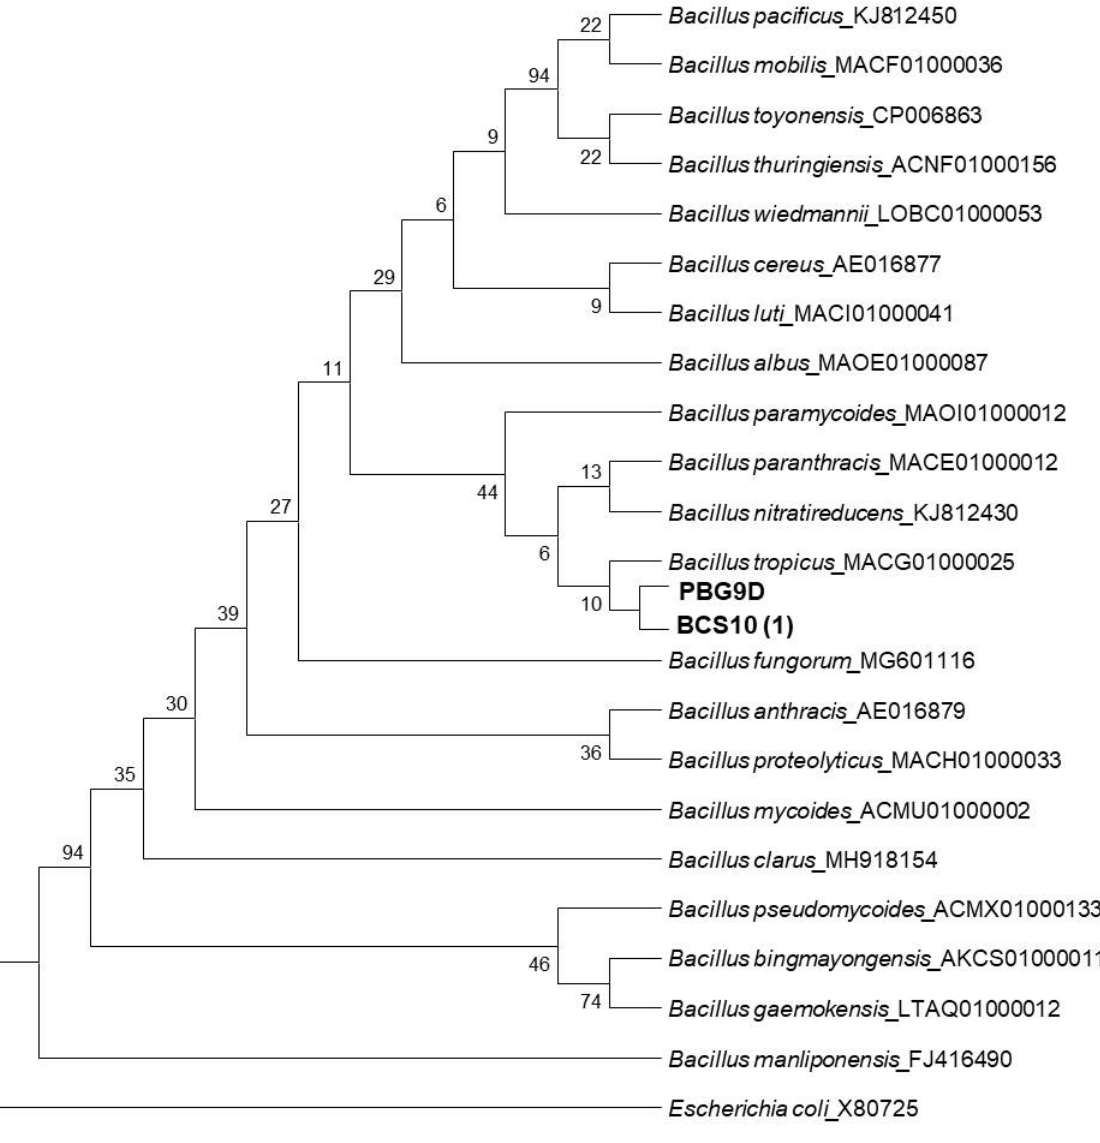
Figure 5. Phylogeny tree showing closely related species of the